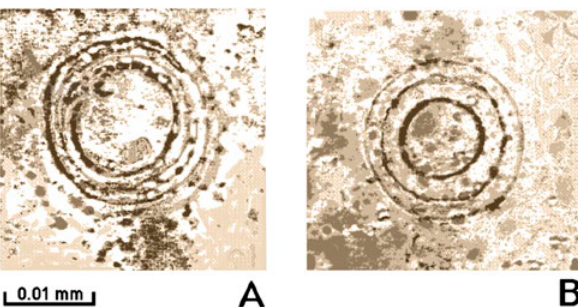
Figure 56. Examples of silica microspheres or concretions of silica in chert from the siderite-chert facies of the Gunflint Iron Forma- tion, Kakabeka Falls, Ontario. These silica in silica concretions illustrated by Lougheed 4 (1983, p. 327) may be coated sparsely with micron-sized carbonate crystals (white) and carbon flecks (spots and dusting).